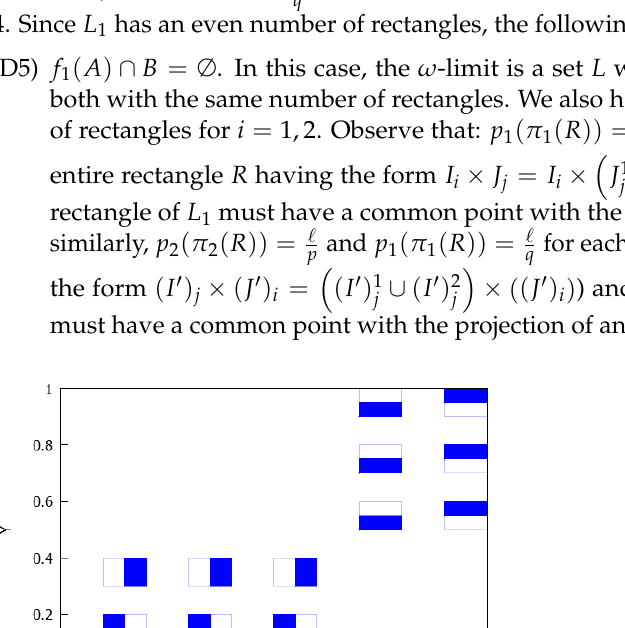
and p 2 ( π 2 ( R )) = 2 = (cid:96) , whereas each ‘entire’ rectangle p q and p 1 ( π 1 ( R (cid:48) )) = 2 = (cid:96) p q